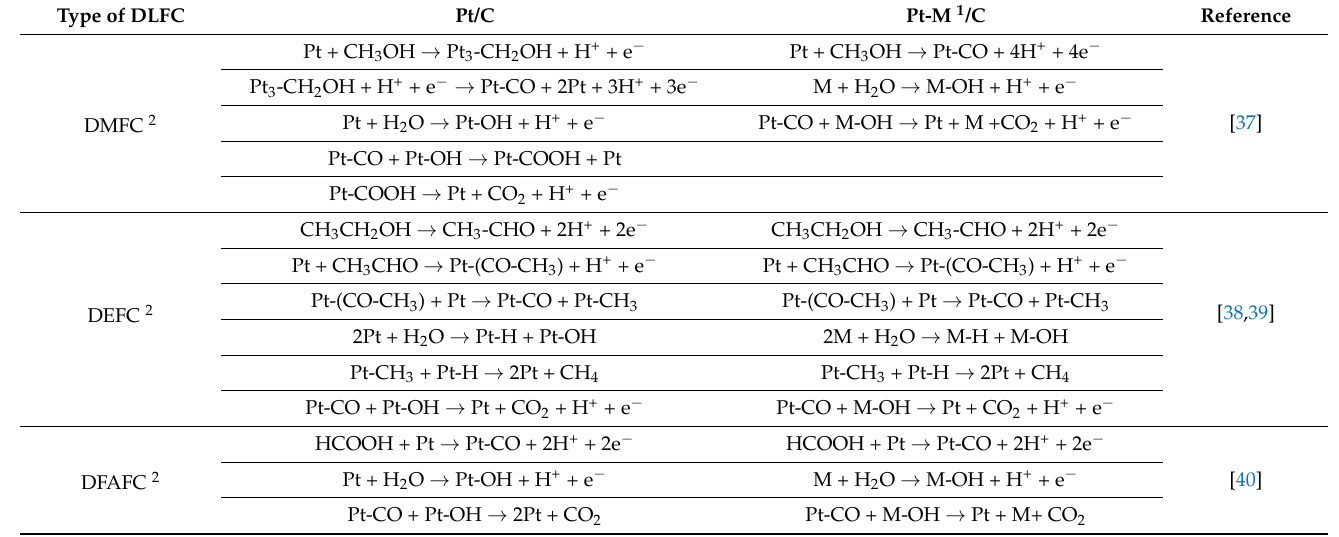
Figure 1. A summary of the progress in development associated with Pt-Ru catalysts utilising electrodeposition. Pt(dba) 2 —Bis(dibenzylideneacetone)platinum; Ru(COD)(COT)—organometallic Ru precursor; COD—1,5-cyclooctadiene; COT = 1,3,5-cyclooctatriene [35,36]. Table 2. A comparison of the anodic oxidation of DLFCs employing Pt/C and Pt-M/C catalysts. Pt-M 1 /C